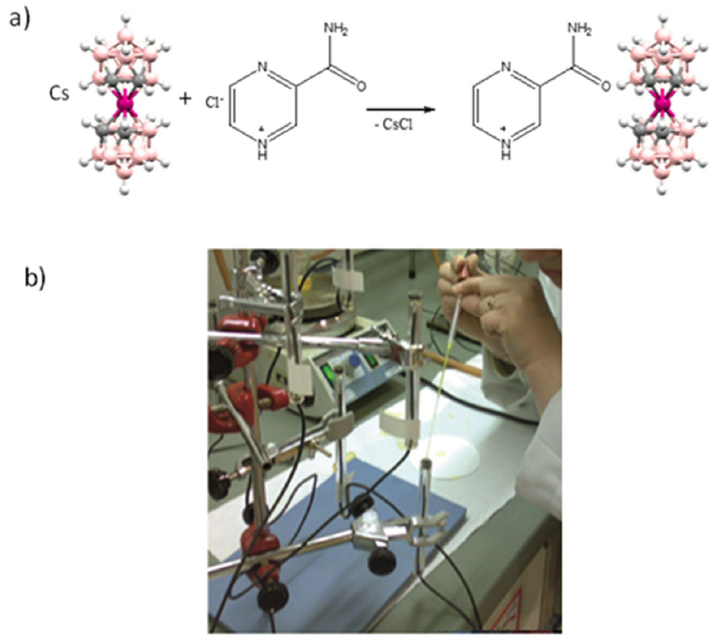
Figure 4. ( a ) Synthesis of the electro-active [YH] x [3,3Co(1,2-C 2 B 9 H 11 ) 2 ] y salt for pyrazinamide (PZA). ( b ) Photo showing the simplicity of the ISE electrode preparation.